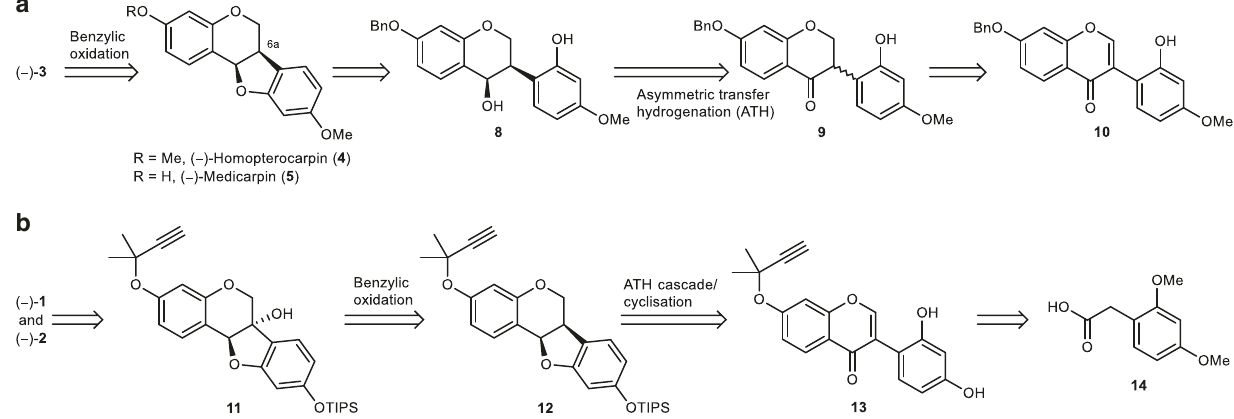
Fig. 2 Retrosynthetic analysis of 6a-hydroxypterocarpans. a Synthesis of ( − )-variabilin ( 3 ) via biomimetic benzylic oxidation of ( − )-homopterocarpin ( 4 ). The pterocarpan skeleton is traced back to iso fl avan-4-ol 8 which is generated by asymmetric transfer hydrogenation (ATH). b Synthesis of ( − )-glyceollin I ( 1 ) and ( − )-glyceollin II ( 2 ) via a one-pot transformation from iso fl avone 13 to pterocarpan 12 involving an ATH cascade and acid- catalysed cyclisation.